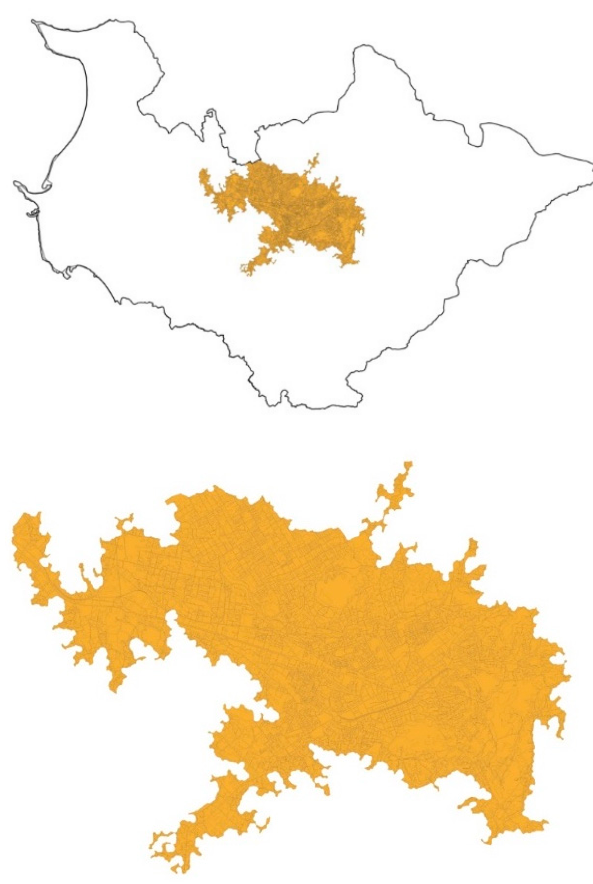
Figure 7. Tirana’s urban area within Tirana’s entire region.